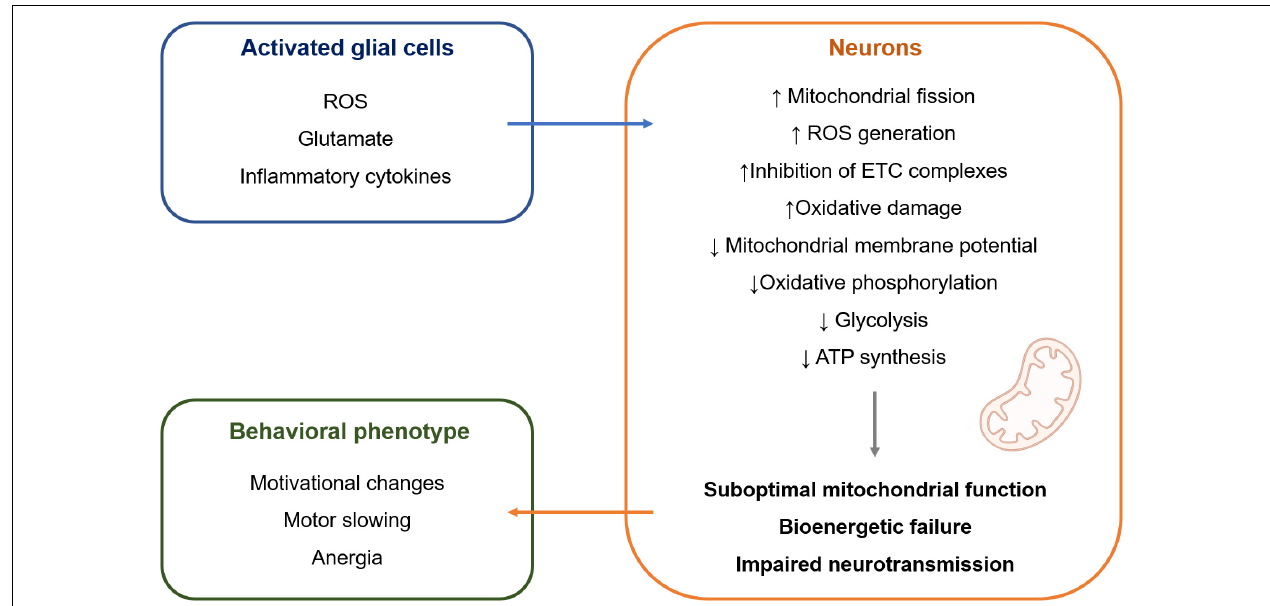
FIGURE 1 | Hypothetical model of intercellular crosstalk during inflammation-associated depression. Activated glial cells release a wide range of molecules (Garden and Möller, 2006; Takeuchi et al., 2006; Hanisch and Kettenmann, 2007) that can impair mitochondrial structure and function in adjacent neurons (Brown